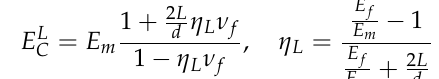
Table 1. Experimental moduli values of the matrix ( E m ), fibers ( E Saffil ), particles ( E SiC ), hybrid L-sample ( ex ) , and hybrid T-sample E T E L H ( th ) , Mg + Saffil in the T direction E T E L C